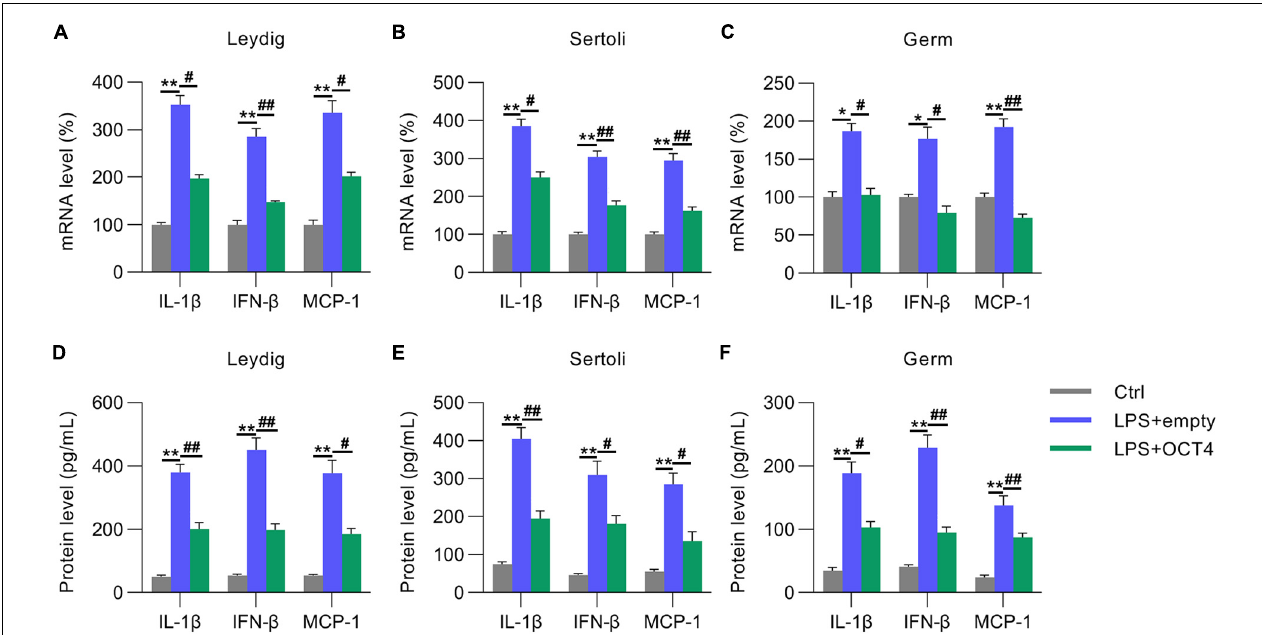
FIGURE 4 | Role of OCT4 overexpression in inflammation. Leydig, Sertoli, and germ cells were transfected with pcDNA3-OCT4 or pcDNA3-NC and then incubated with LPS for 12 h. (A–C) Total RNA was extracted, and the relative mRNA levels of IL-1 β , IFN- β , and MCP-1 in the cells were determined using RT-qPCR. (D–F) ELISA was conducted to examine secreted IL-1 β , IFN- β , and MCP-1 levels in the cells. Data are expressed as the means ± SDs. * P < 0.05, ** P < 0.01, Ctrl vs. LPS + empty; # P < 0.05, ## P < 0.01, LPS + empty vs. LPS +